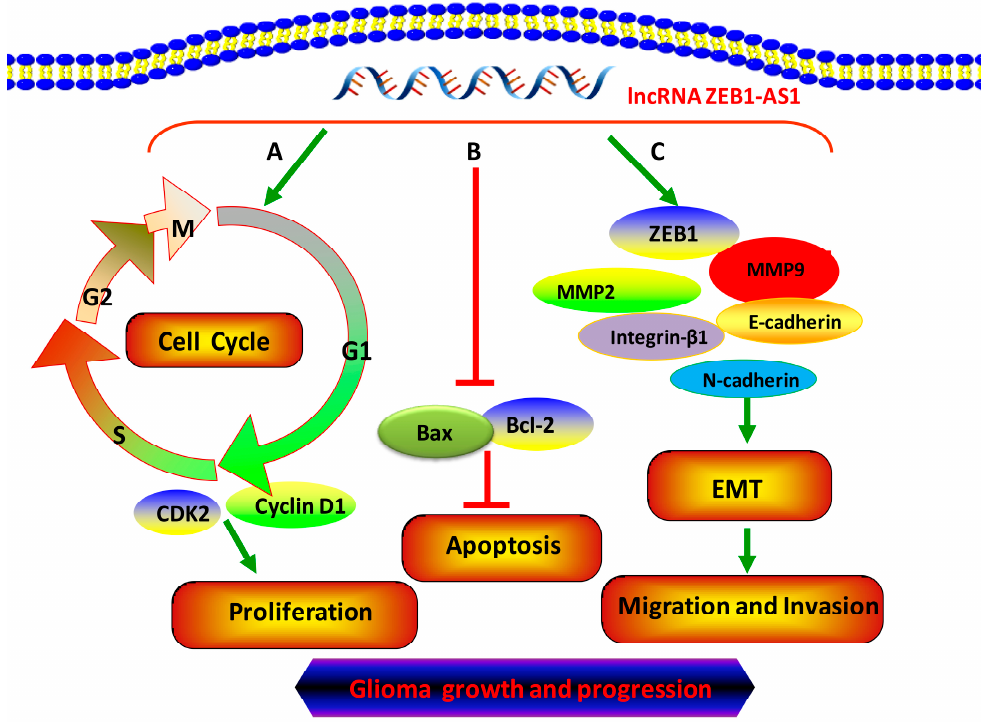
Figure 7. lncRNA ZEB1-AS1 was a key regulator of glioma proliferation, apoptosis, migration, and invasion. ( A ) ZEB1-AS1 promoted the proliferation by significantly inducing the G0/G1 phase arrest and correspondingly decreasing the percentage of S phase in cell cycle; ( B ) ZEB1-AS1 inhibited the apoptosis of glioma cells; ( C ) ZEB1-AS1 activated EMT through up-regulating the expression of MMP2, MMP9, N-cadherin, and Integrin- β 1 as well as decreasing E-cadherin levels and accelerating the migration and invasion of glioma cells.